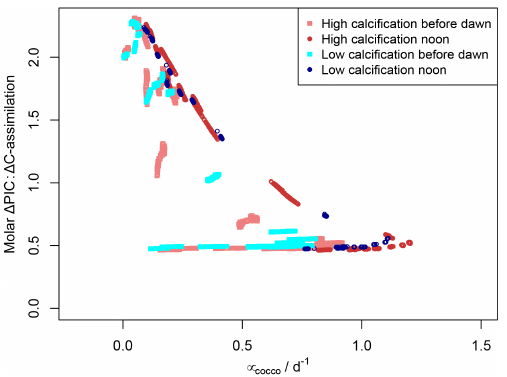
Figure 6. Molar calcification-to-C-fixation ratio compared to net growth rate of coccos ( µ cocco ) in high and low calcification solu- tions.